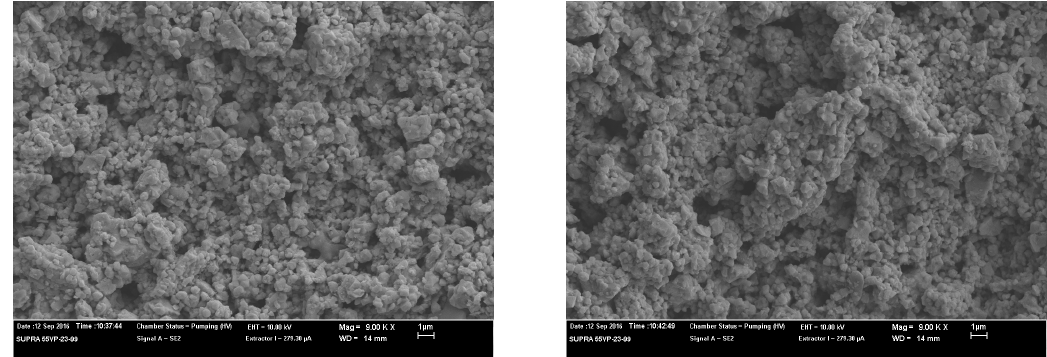
Figure 2. SEM images of Pd-In 2 O 3 ( left ) and Pt-In 2 O 3 ( right ).